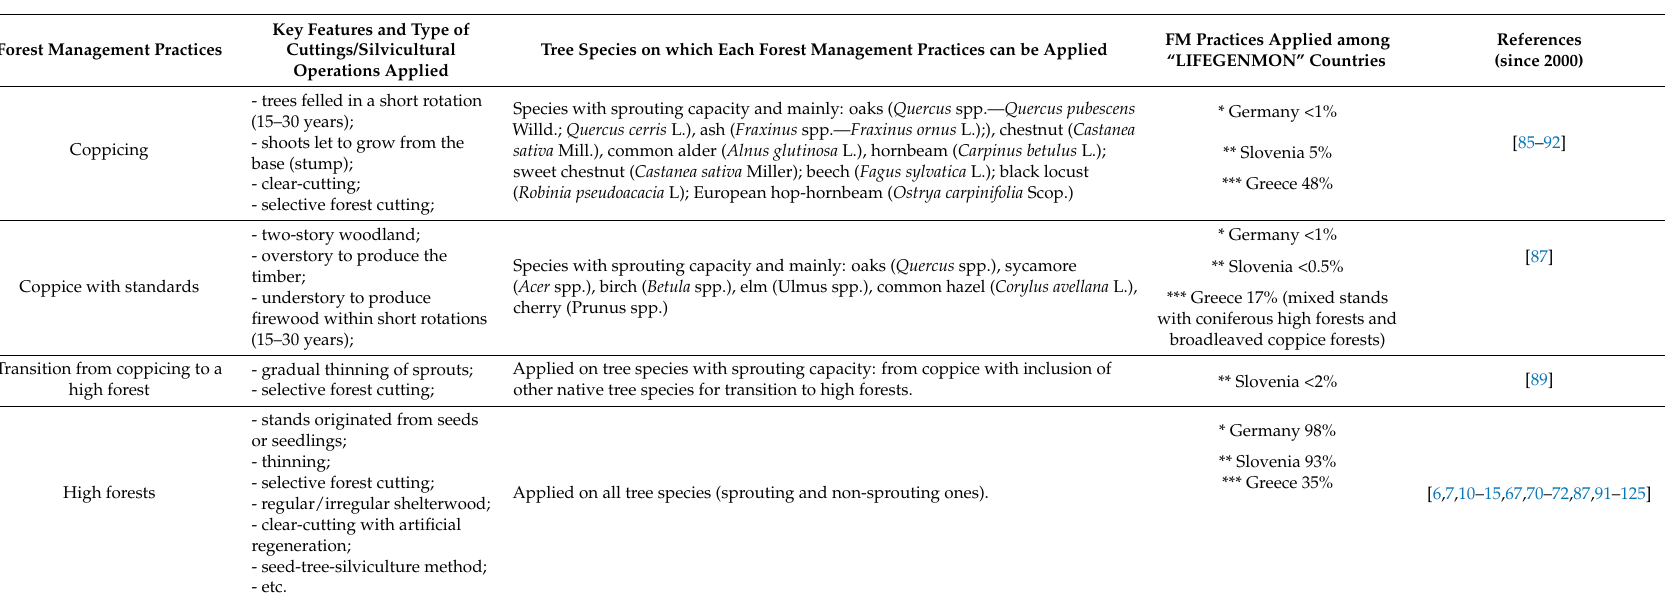
Table 2. Compilation of forest management practices and related studies focusing on the influence of FM practices on genetic variation of forest stands.